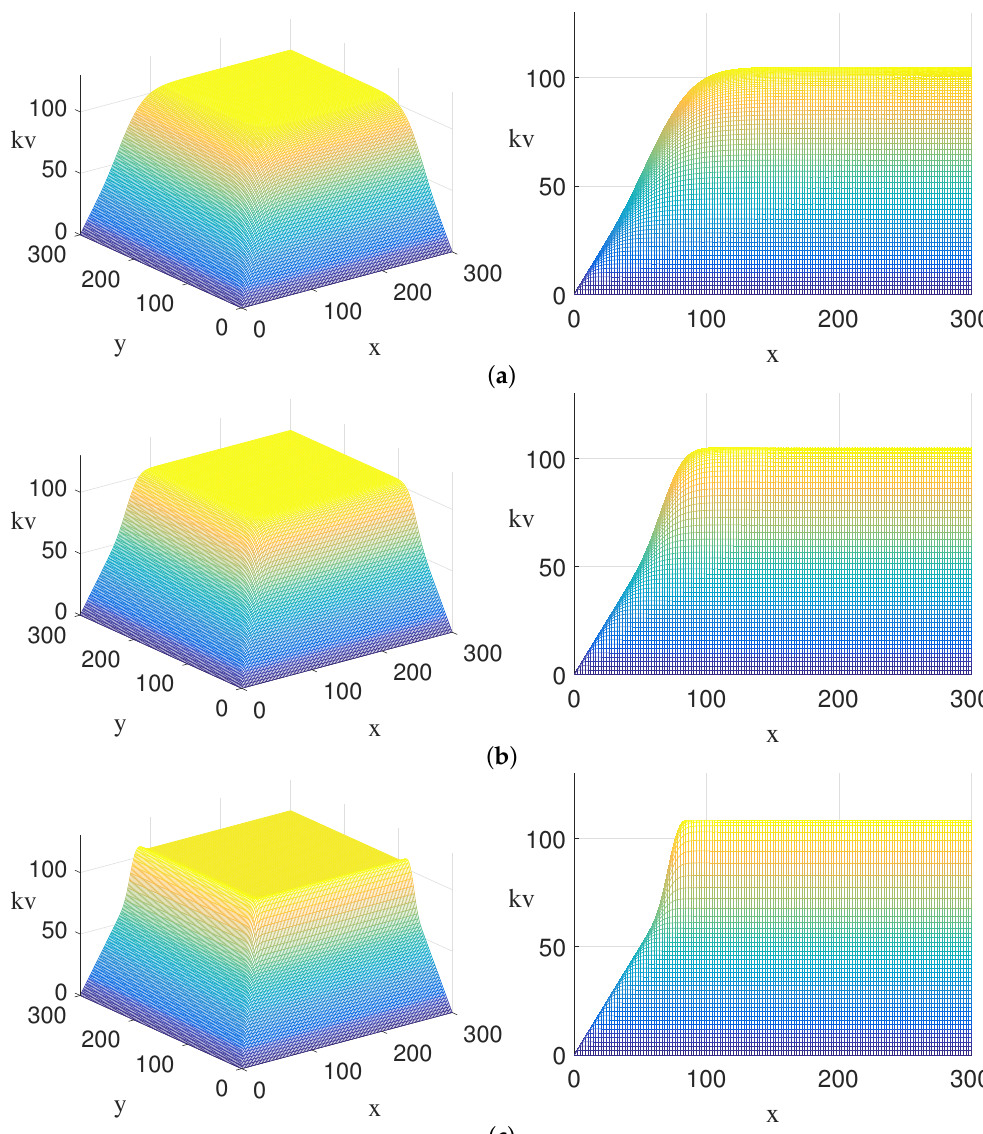
Figure 7. ( a ) denotes kv for different x , y when H x = H y = 0.3, ( b ) denotes kv for different x , y when H x = H y = 0.5 and (c) denotes kv for different x , y when H x = H y = 0.7.